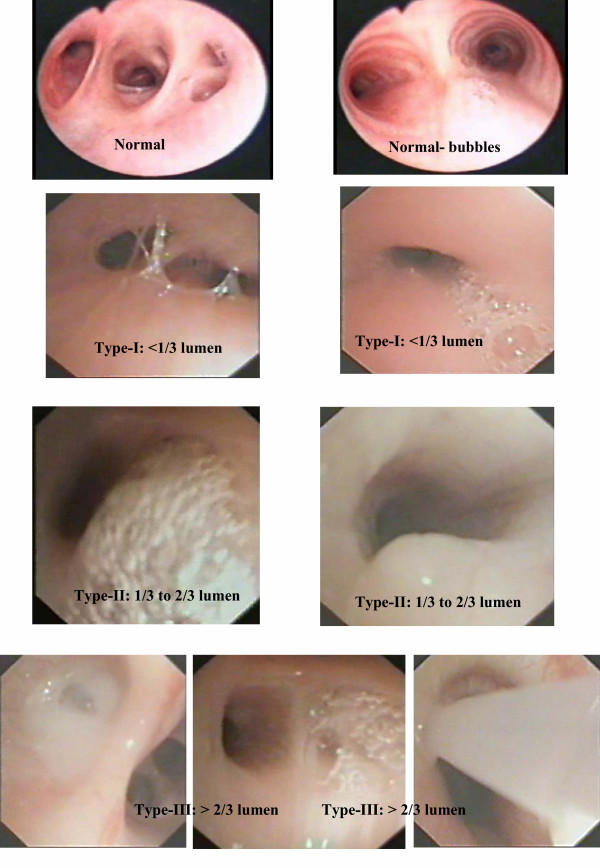
Bronchoscopic secretion quantification card.